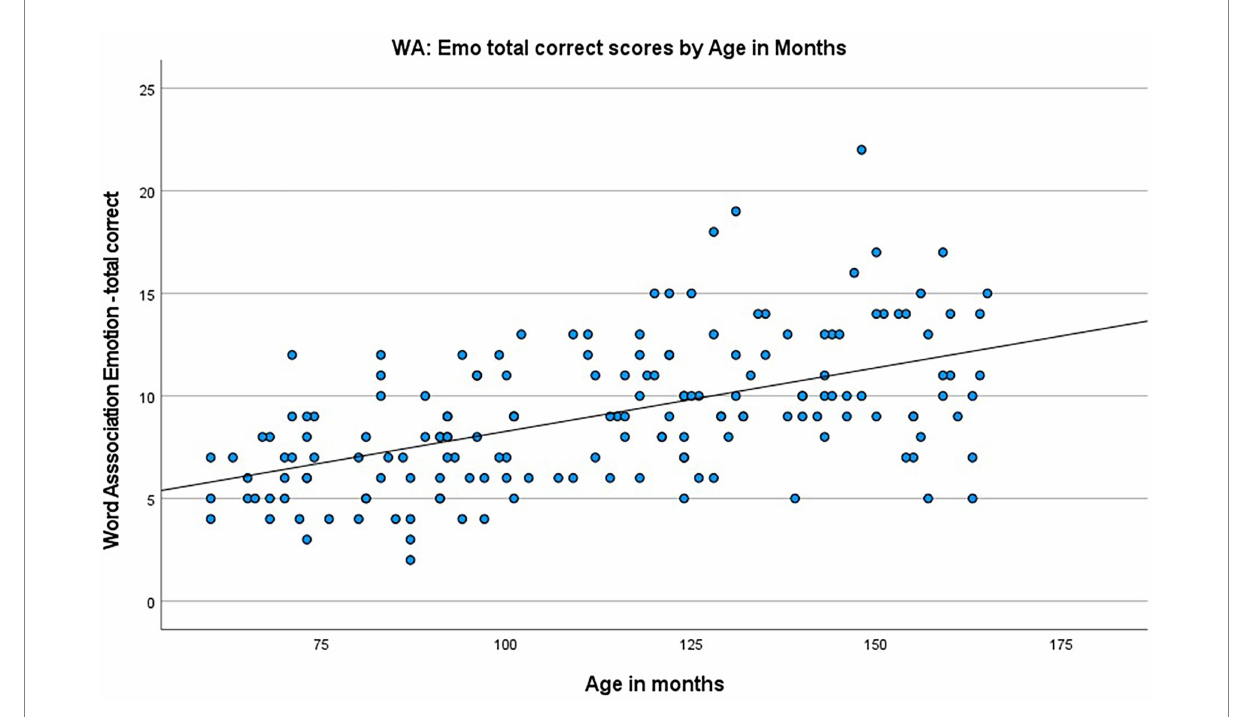
FIGURE 4 Scatterplot showing the correlation between WA:Emo scores and age in month.